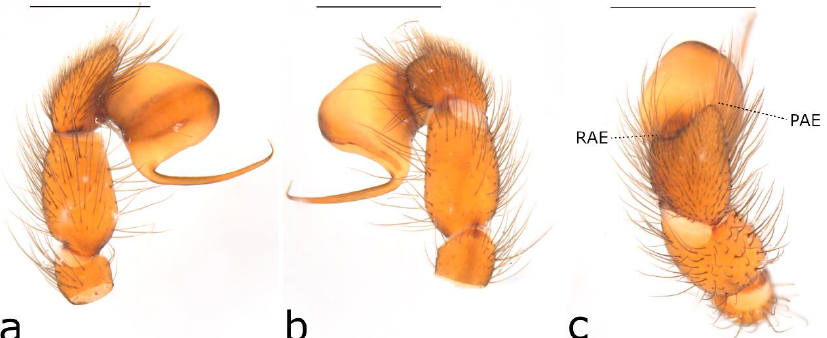
Figure 5. Ariadna clavata Marsh, Baehr, Glatz & Framenau, 2018. ♂ holotype (SAMA NN29861) from Kangaroo Island (SA): ( a ) left pedipalp, prolateral view; ( b ) same, retrolateral view; ( c ) same, cymbium. Scale bar = 0.5 mm.